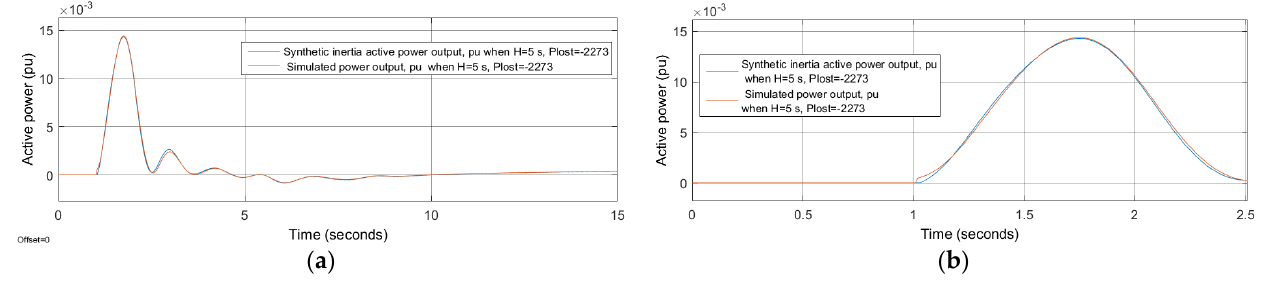
Figure 5. Comparison of active power outputs of the SI algorithm and simulated power output when H = 5 s and there is 2273 MW loss of generation. ( a ) Modeling result displayed in 15 s scale; ( b ) the same modeling results displayed in 2 s.